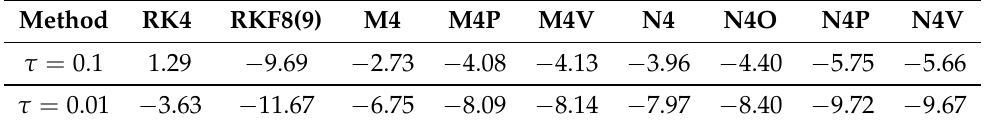
Table 1. Energy errors for the algorithms in Figure 1a,c. Because RKF8(9) uses variable time steps, τ = 0.1 and 0.01 are not time steps but are time intervals for outputting data. Note that 1.29 denotes the error with an order of 10 1.29 , − 9.69 means the error with an order of 10 − 9.69 , and so on.